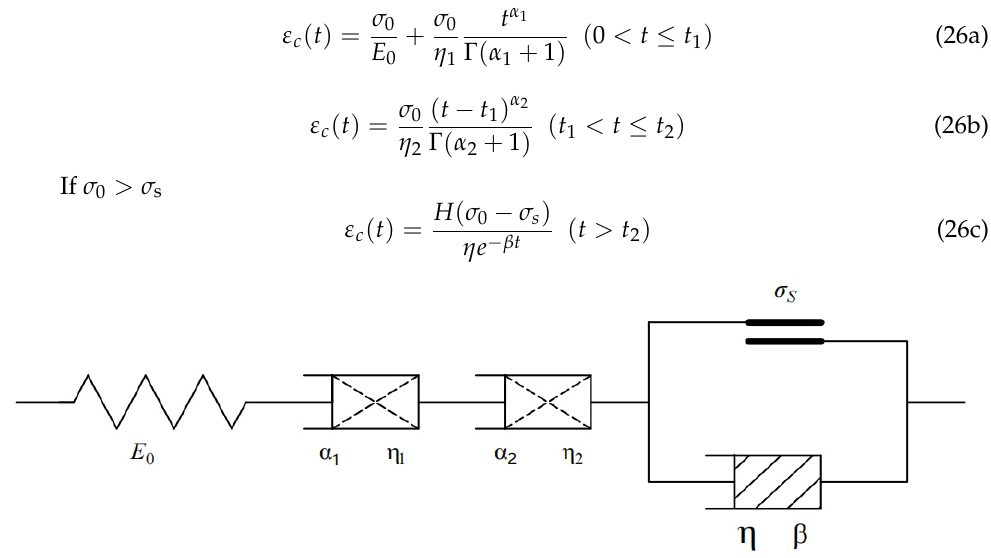
Figure 11. Improved variable-order fractional creep constitutive model.